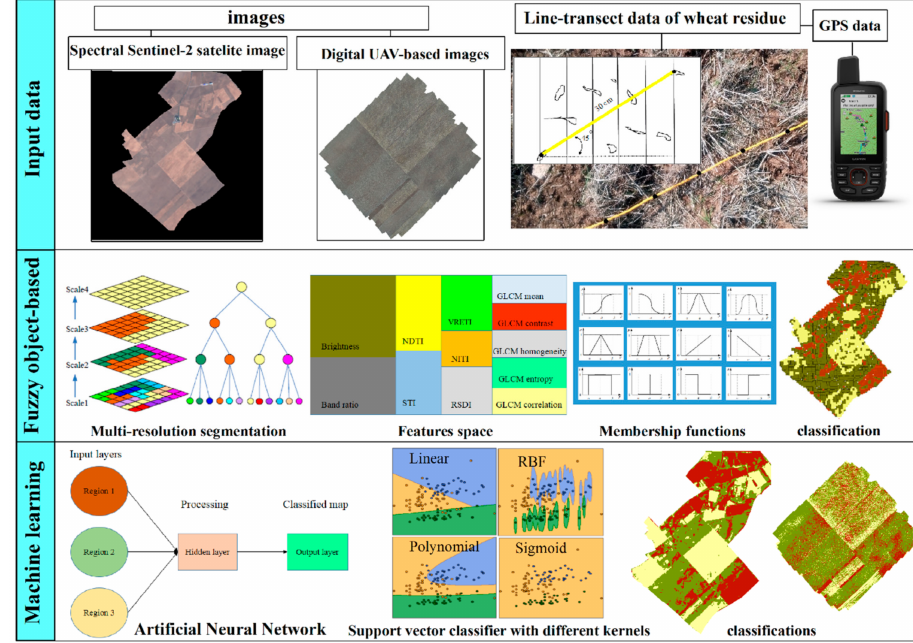
Figure 2. Overview of the